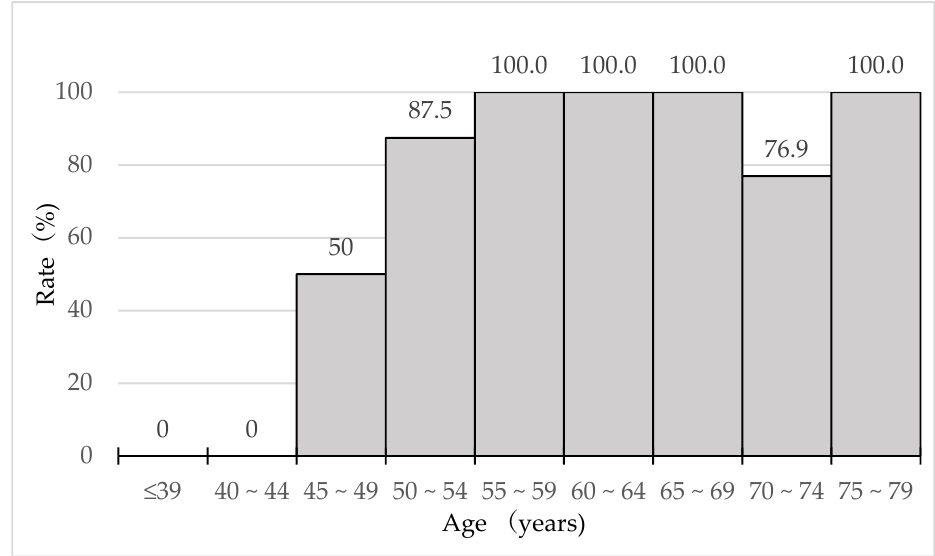
Figure 2. Rate of the patients with awareness of presbyopia.